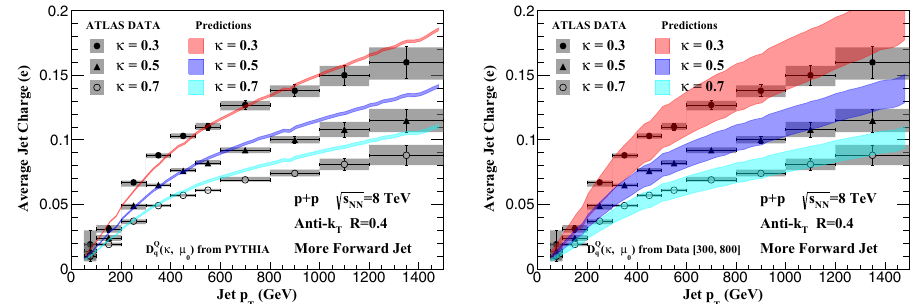
Figure 2. Transverse momentum dependence of the average jet charge distributions for more forward jets in dijet events at √ s NN = 8 TeV in p + p collisions. The non-perturbative parameters are obtained by fitting to PYTHIA simulations (left) and ATLAS measurements